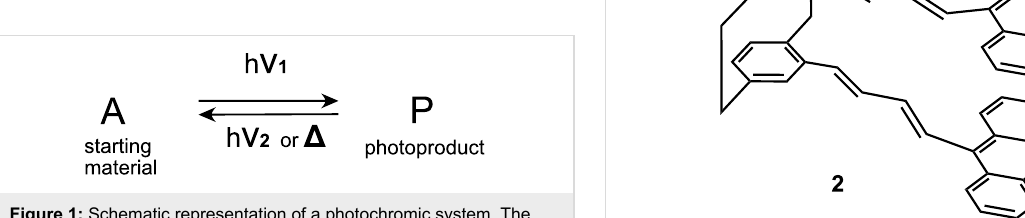
Figure 1: Schematic representation of a photochromic system. The reverse reaction can be a photochemical or thermal process. A and P have different absorption spectra.